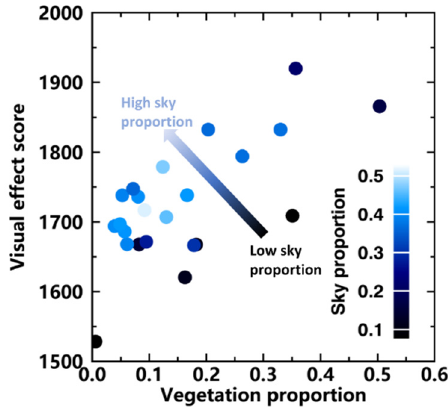
Figure 10. Relationship between visual effect score, vegetation proportion, and sky proportion.